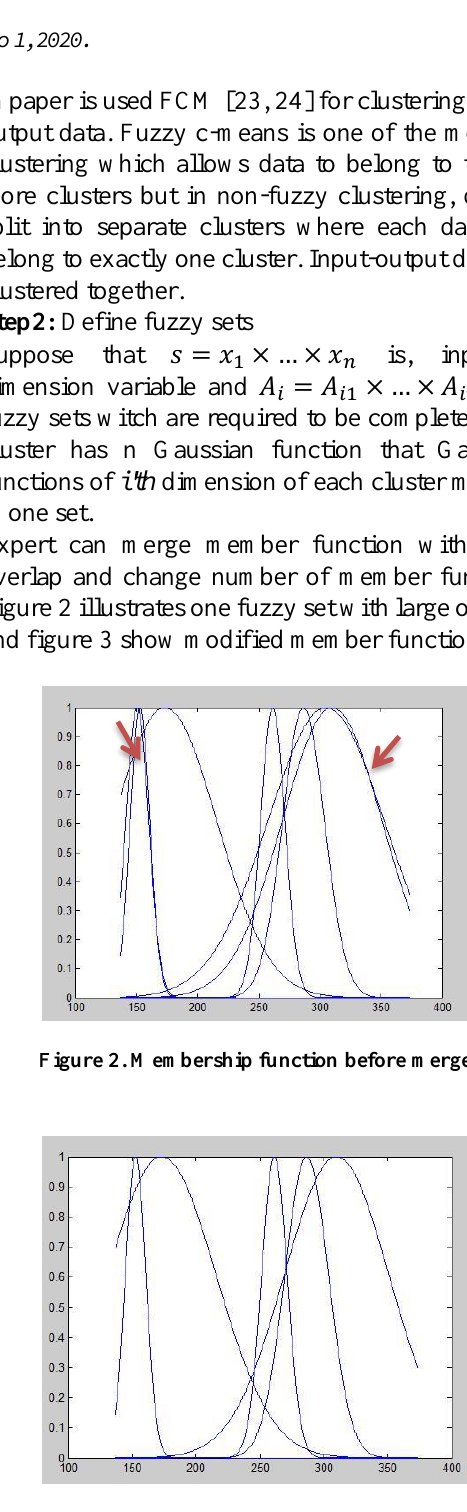
Figure 3. Membership function after